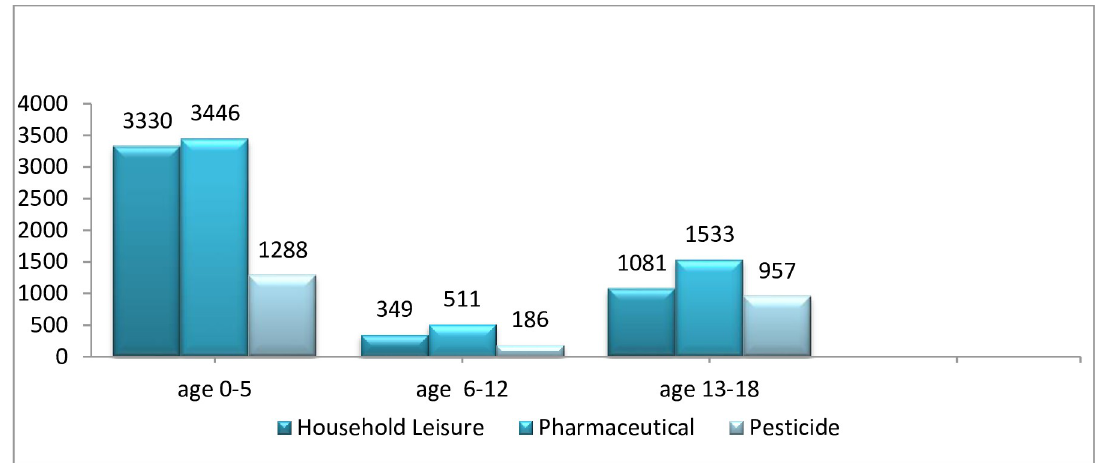
Fig 2. Distribution of number of poisoning cases in age group according to type of poisoning. https://doi.org/10.1371/journal.pone.0266767.g002 Pharmaceutical agents were the most frequent in all the age groups. The most frequent non- pharmaceutical agents in all the age groups were household agents, as illustrated in Fig 2. Exposure to therapeutic agents and household products together accounted for 10,250 cases or 75% of all reported exposures. When the most frequent poisoning agents within the aforementioned categories in the Fig 2 were identified according to age groups, it was found that within the pharmaceutical group, topical agents, including aromatherapy oils and analgesics, were significant across all ages. Among the household agents, cleaning products were also seen to be significant, while insecti- cides and herbicides were the most common pesticides across all ages (Table 2). The top 10 agents that were commonly the cause of child poisoning were cleansing agents (2,087 cases or 15.4%), followed by topical agents (1,511 cases or 11.1%), while the least